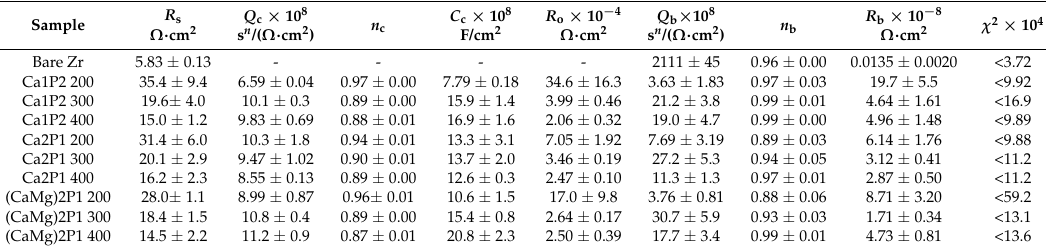
Figure 9. Equivalent electrical circuits (EECs) used for analysis of the electrochemical impedance spectroscopy (EIS) results corresponding to the bare zirconium surface ( a ) and the PEO coatings ( b ). Table 1. Circuit parameters that were obtained from the fitting of the EIS data to the EECs from Figure 9.